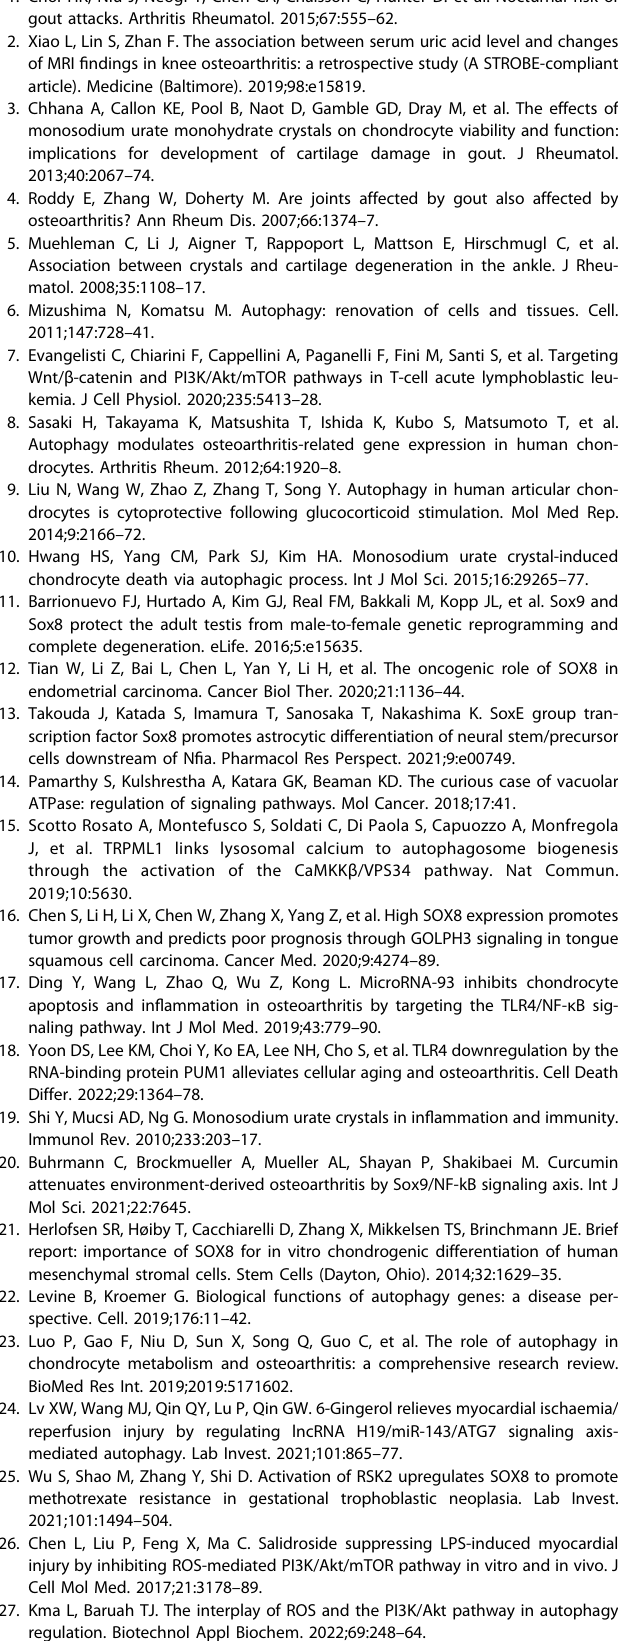
Table 1. Primers used in quantitative real-time